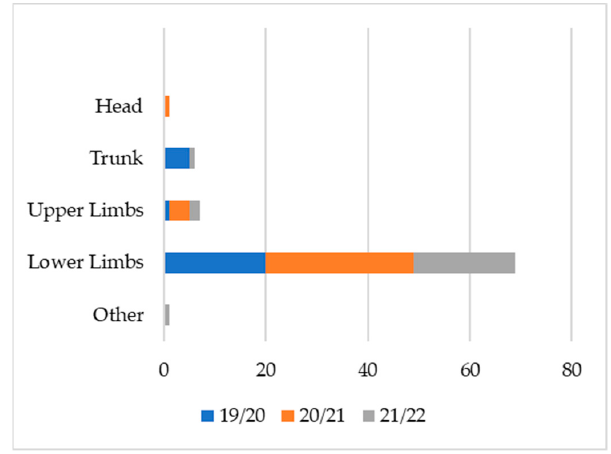
Figure 1. Injury frequency by zone (n).